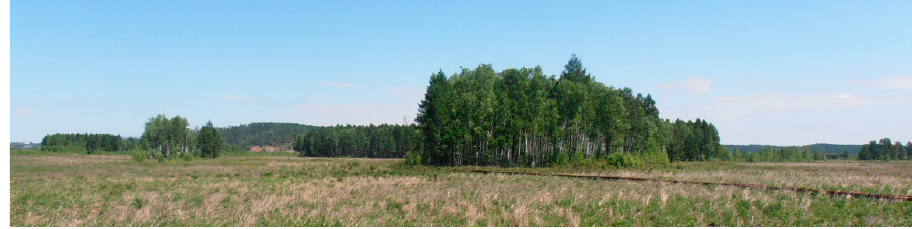
Figure 7. Map of the objects of study in NRWNNR.